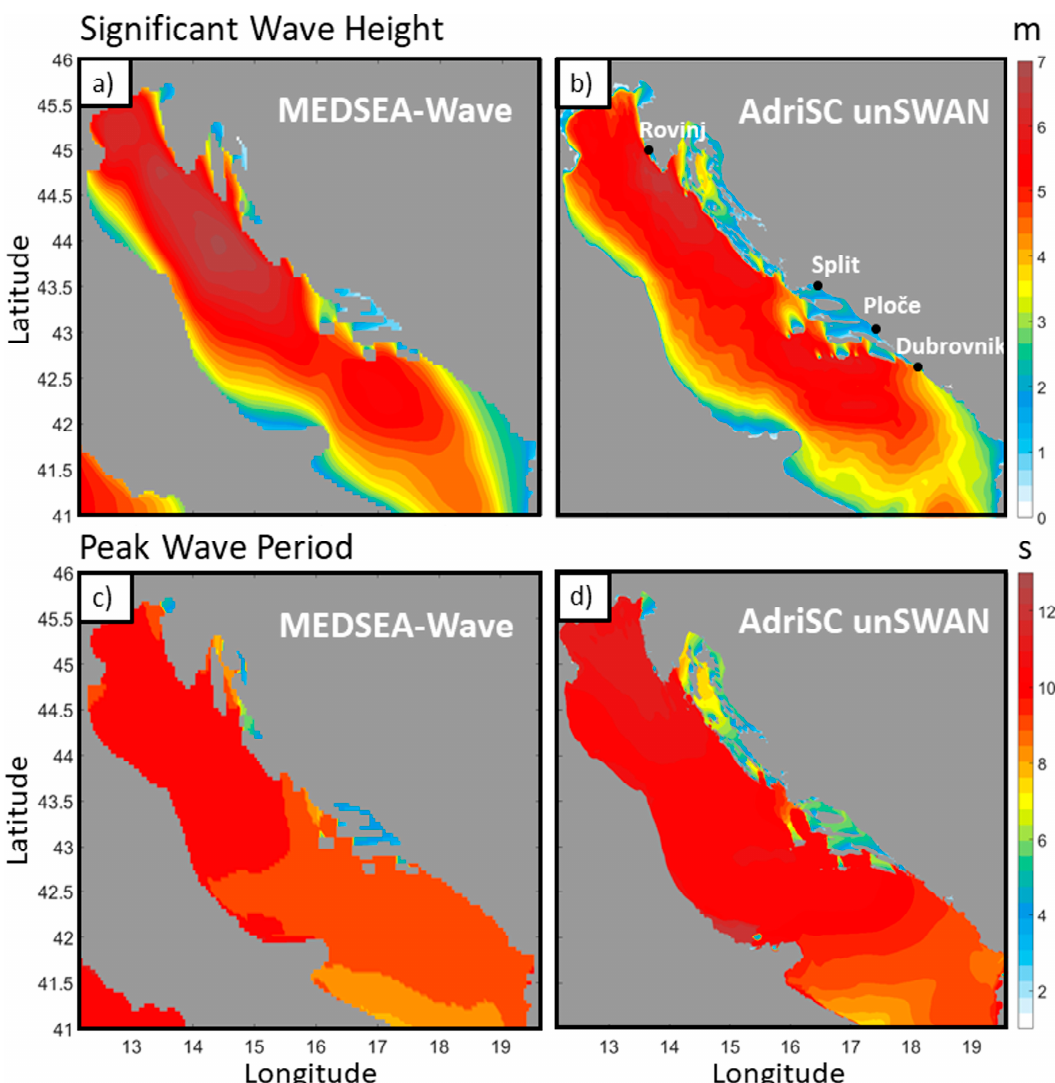
Figure 8. ( a ) Significant wave height using MEDSEA-Wave, ( b ) significant wave height using AdriSC unSWAN, ( c ) peak period using MEDSEA-Wave, and ( d ) peak period using AdriSC unSWAN. All four models are related to 29 October 2018, at 20:00. Table 3. Comparison of the wave parameters (significant wave, height, and peak period) measured by the Croatian Hydrographic Institute at four different locations (Rovinj, Split, Dubrovnik and Plo č e) together with the AdriSC unSWAN model results during the peak of the storm on 29 October 2018. Significant Wave Height [m] Peak Period [s]